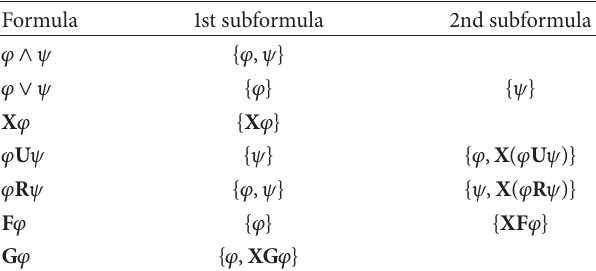
Table 1: Tableau rules for LTL